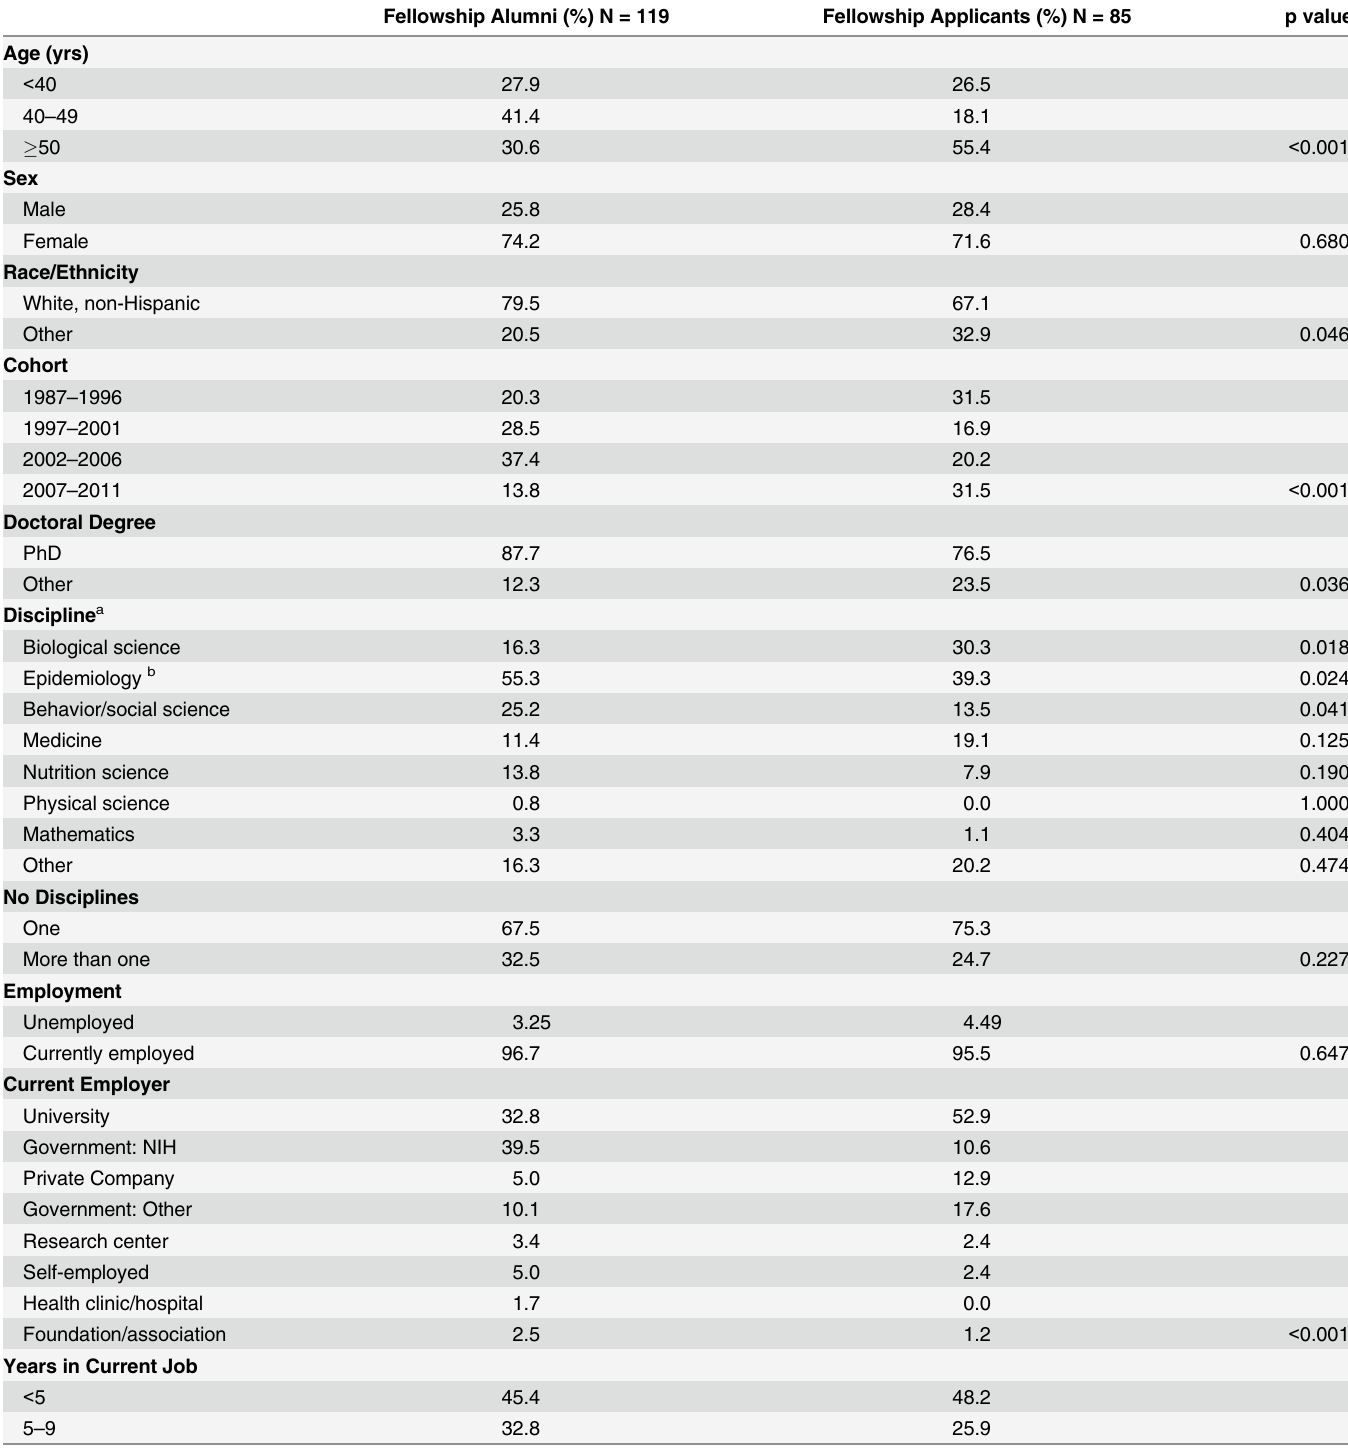
Table 1. Demographic and Other Characteristics of the CPFP Alumni and